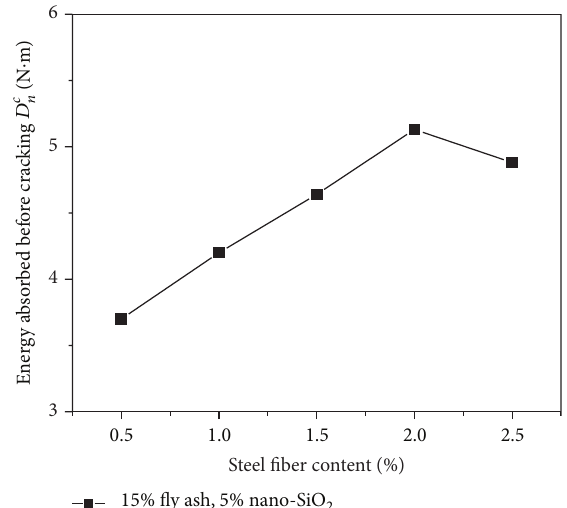
Figure 7: Effect of steel fiber content on energy absorbed before cracking.